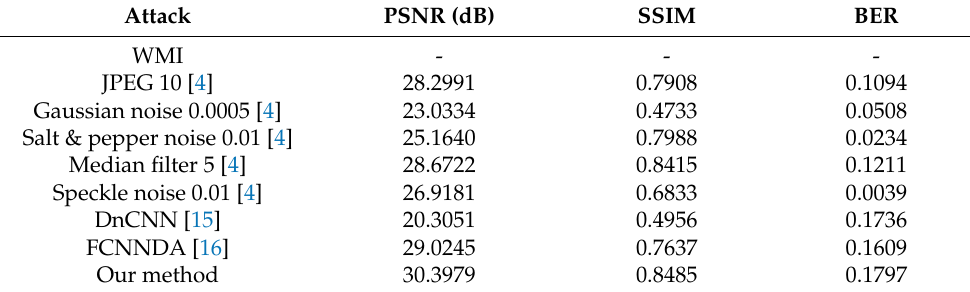
Table 1. Comparison of evaluation indicators; watermark size of 16 × 16. Attack PSNR (dB) SSIM BER